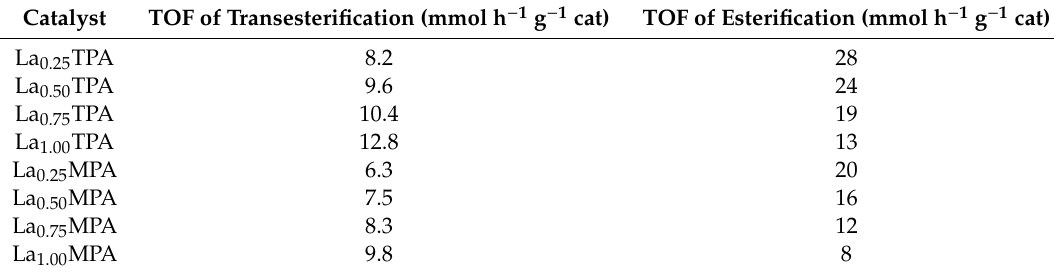
Table 3. TOFs of transesterification of glyceryl tributyrate and palmitic acid esterification over the synthesized